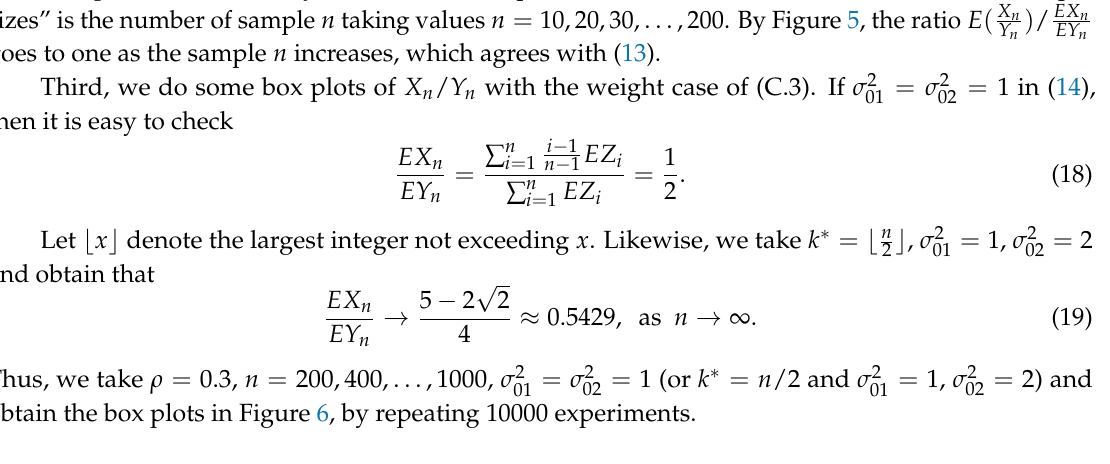
Figure 5. Empirical values of ratio E ( X n = σ 2 = 1, or k ∗ = n /2 and σ 2 ρ = 0.3, σ 2 02 01